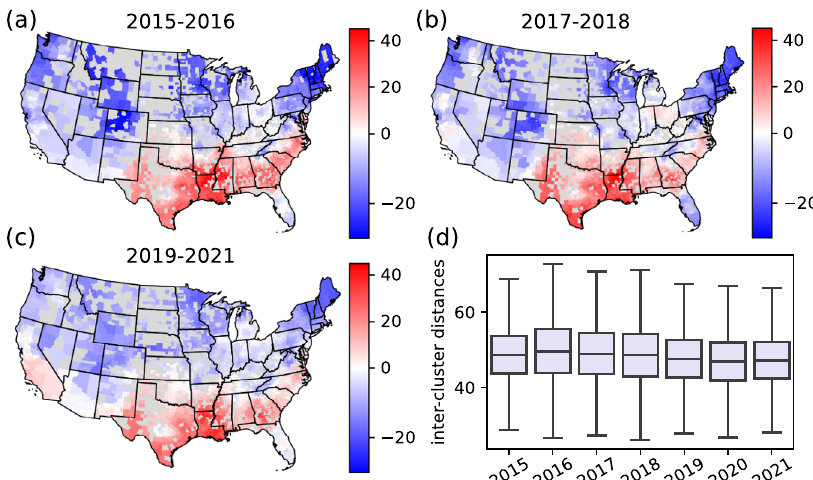
Fig. 5 Effect of temporal segmentation for the data on the obtained divisions. a – c Maps of the data projected along the fi rst PC obtained for the years 2015 – 2016, 2017 – 2018, and 2019 – 2021, respectively. Apart from slight variations in California and Florida, the fi rst component translates the same division between the Southeast and the rest of the US. Note that the scale on the divergent color scales is not symmetrical around zero in order to utilize the full range of colors of the color map. d Evolution of the distributions of inter-cluster distances along the years spanned by our dataset. The box plots show the median, fi rst and third quartile, and the boundaries of the whiskers are within the 1.5 interquartile range value. We use the cluster assignment obtained with the whole dataset and measure the Euclidean distance in G (cid:1) i space between counties belonging to different counties. The distribution is thus shown to vary little from year to year, which demonstrates the stability of the two-way division we